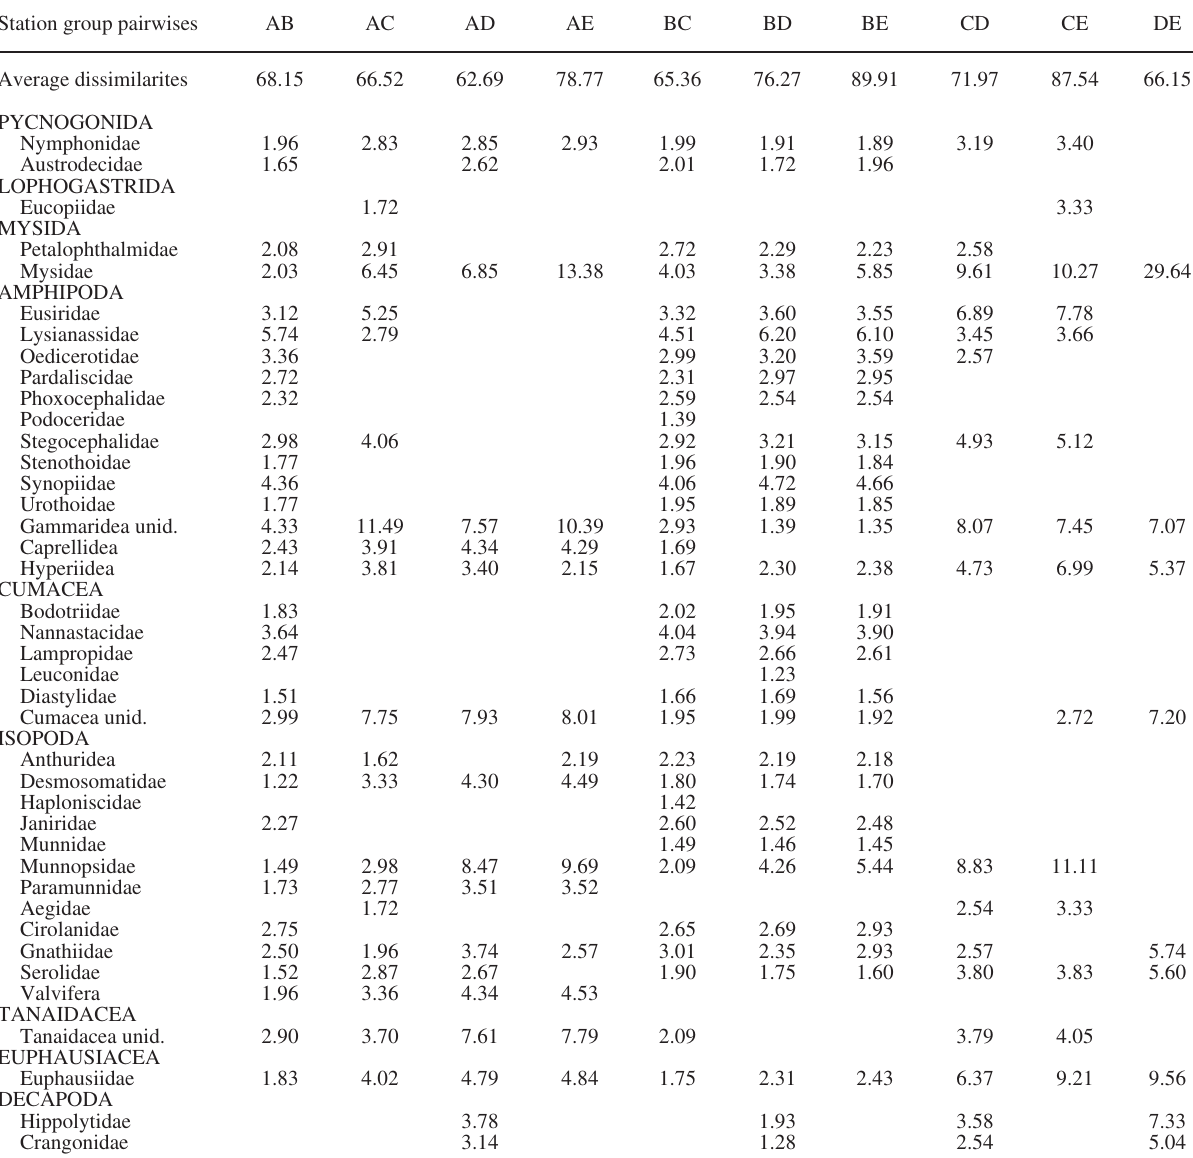
Table 6. – results of simPer analysis. average dissimilarities between station groups pairwise discriminated by the multivariate analysis of the 35 sampling stations and contribution (%) of each taxon to total dissimilarity within each pair. a cut-off at a cumulative dissimilarity of 80% was applied to the data